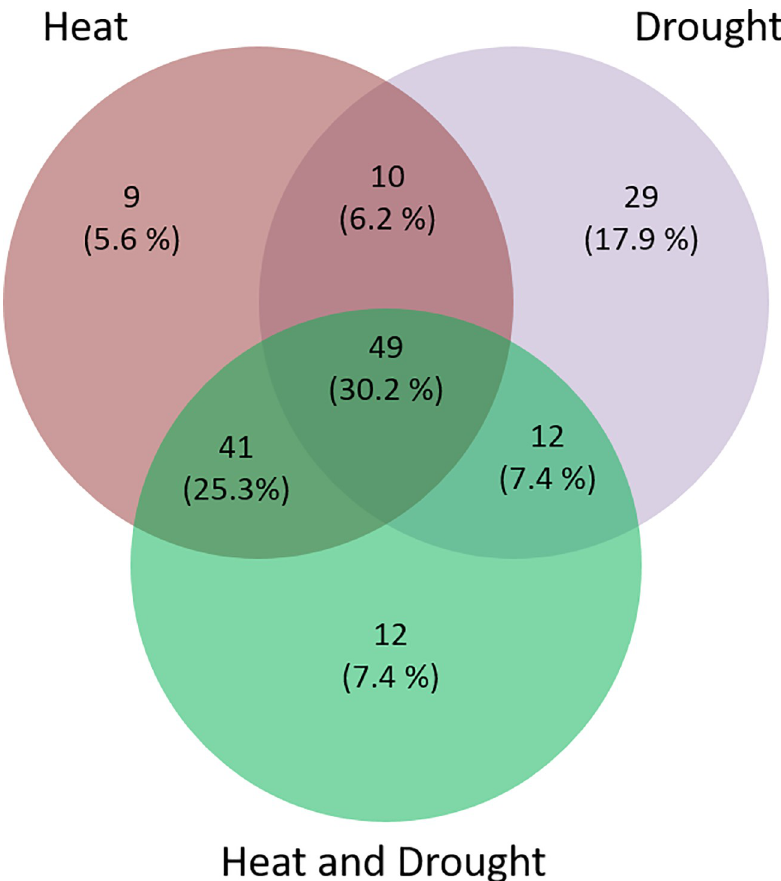
Fig 5. Venn diagram of the 162 differentially expressed TaNAC genes in response to heat, drought, and heat + drought stress.